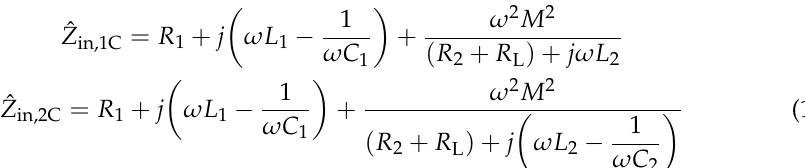
Figure 4. Rotary transformer with series compensation of X in : ( a ) single-capacitor compensation and ( b ) dual-capacitor